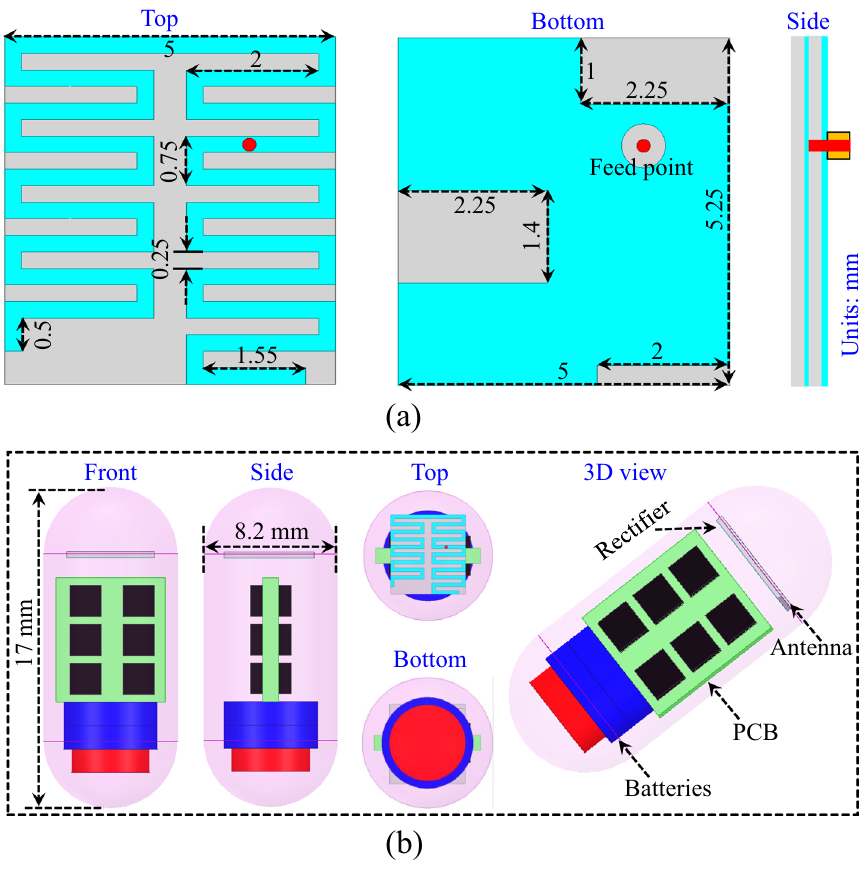
Figure 7. ( a ) Geometry of the proposed dual-band implantable antenna. ( b ) Deep-body device architecture.